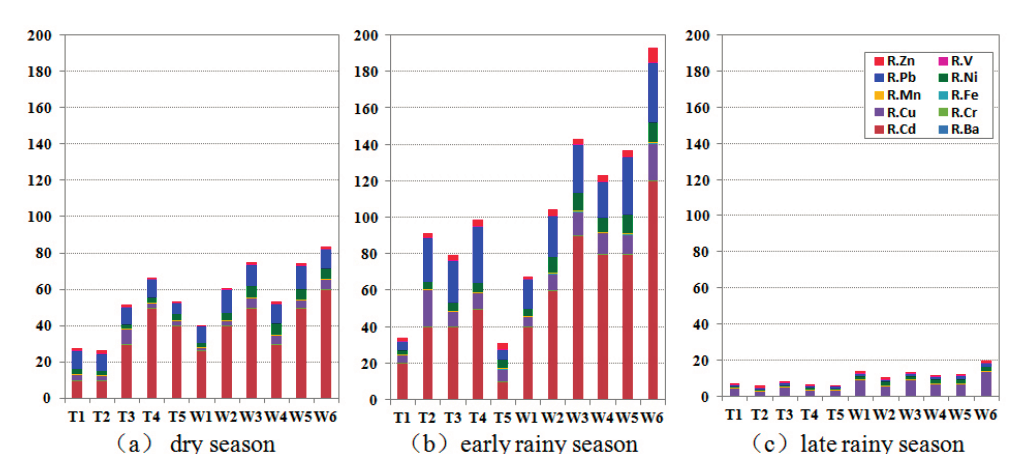
Figure 2. Accumulated column chart of risk ratios of the ten